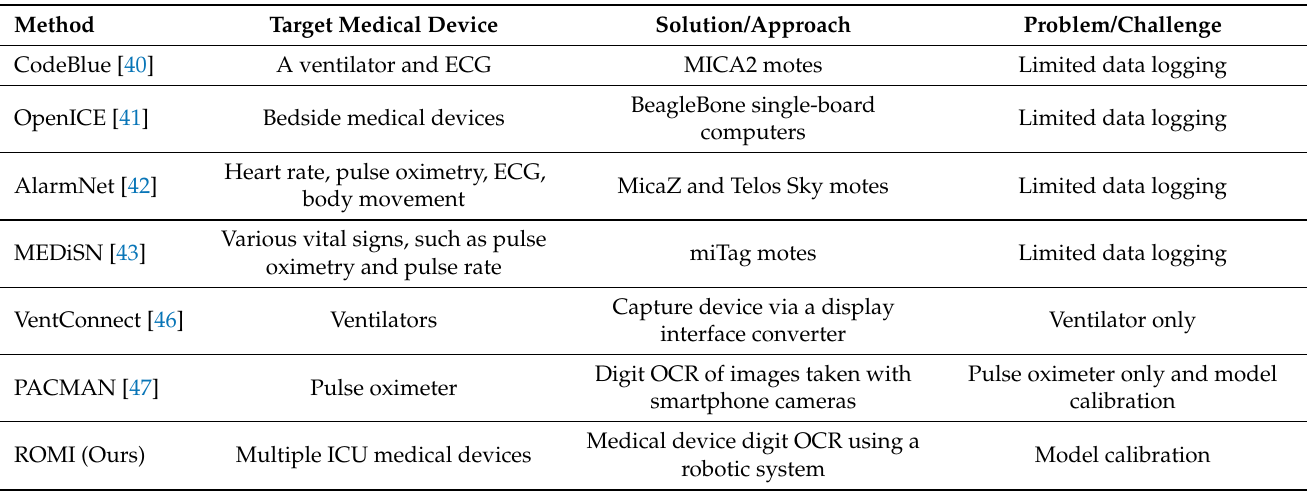
Table 1. Related work on monitoring and integrating medical